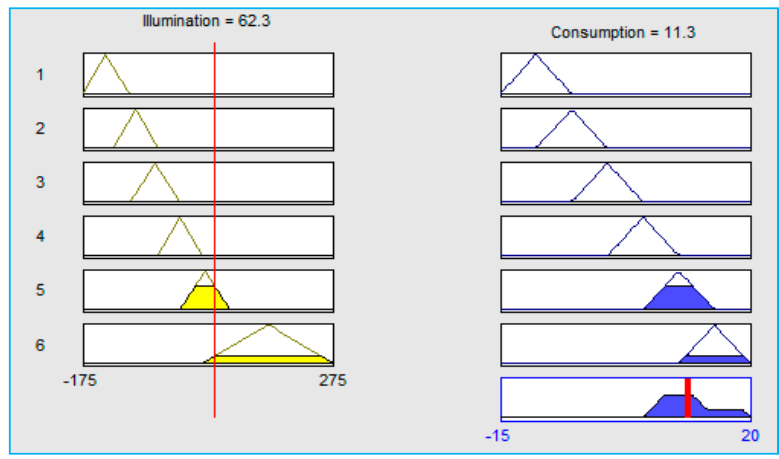
Figure 13. Example of fuzzy rule used in illumination fuzzy logic.